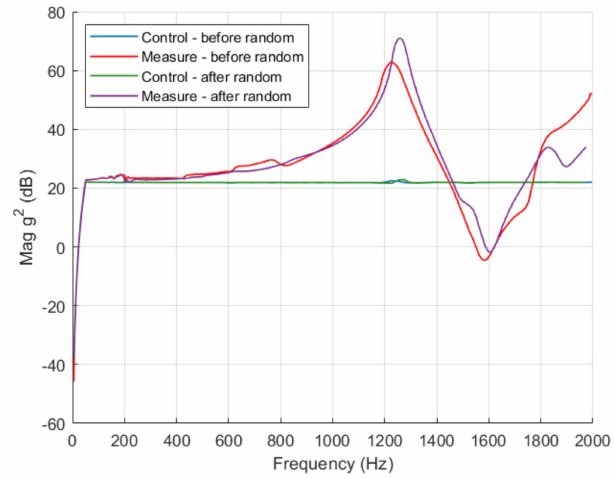
Figure 7. Resonances before and after tests on x axis, AA 6081 spindle.